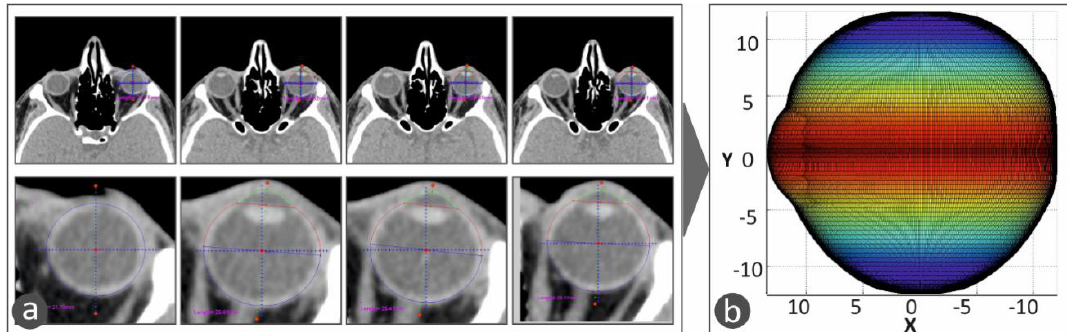
Figure 3. The 3D model of the human eye in the developed software. A color scale was used in the vertical direction to show the human eye height vs. the change in the human eye section size in the horizontal direction: ( a ) CT scan images in which the perimeter of the eye is determined and acquired, ( b ) 3D geometric model of the eye determined from the CT scan images and represented with a color scale